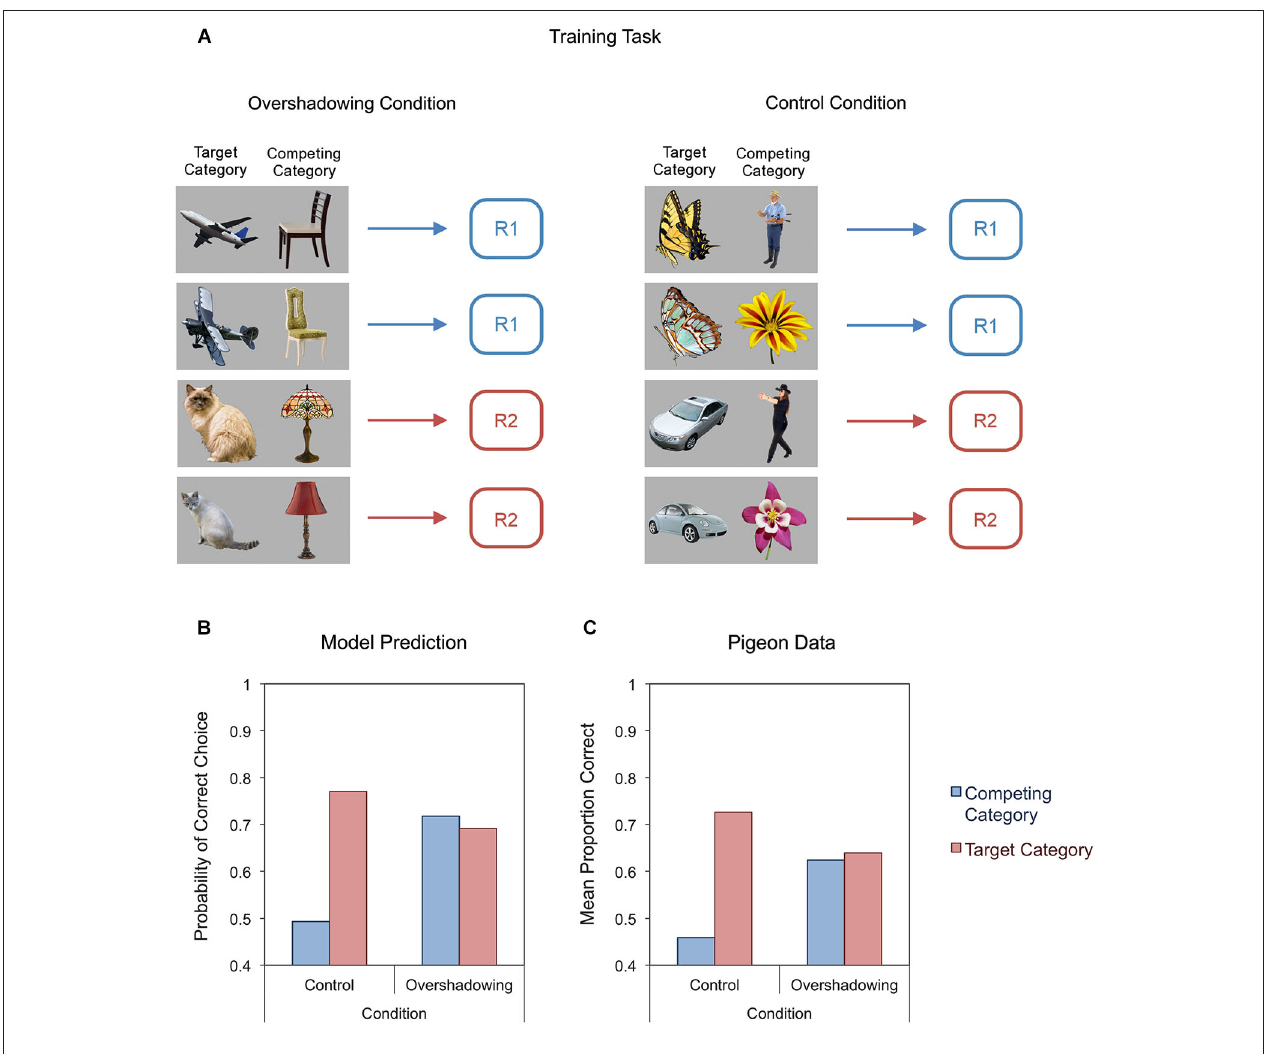
FIGURE 7 | Schematic diagram of an experiment on overshadowing of object category learning (A), together with our model’s predictions (B) and experimental results from an